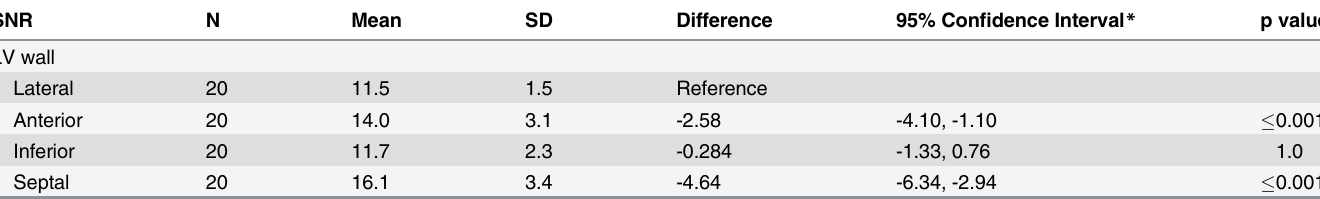
Table 6. SNR Regional Analysis. Lateral wall used as the reference for statistical